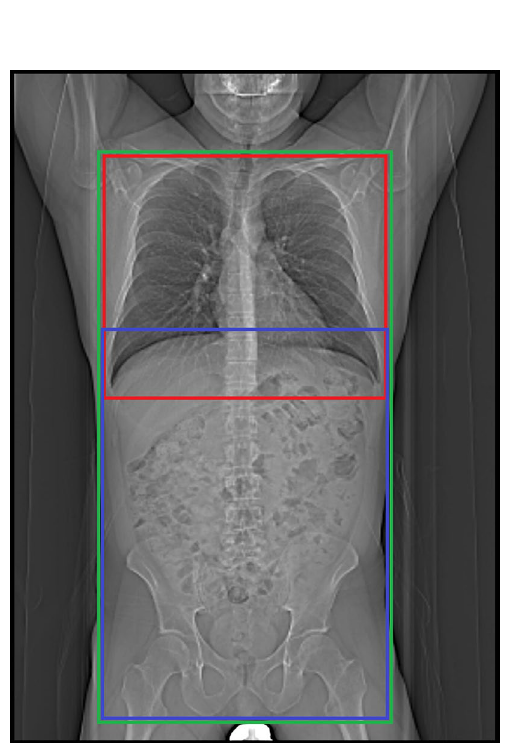
Fig. 2 CT planning scout. Green: scout for thoracoabdominal CT. Red: examined region in thoracic CT alone. Blue: examined region